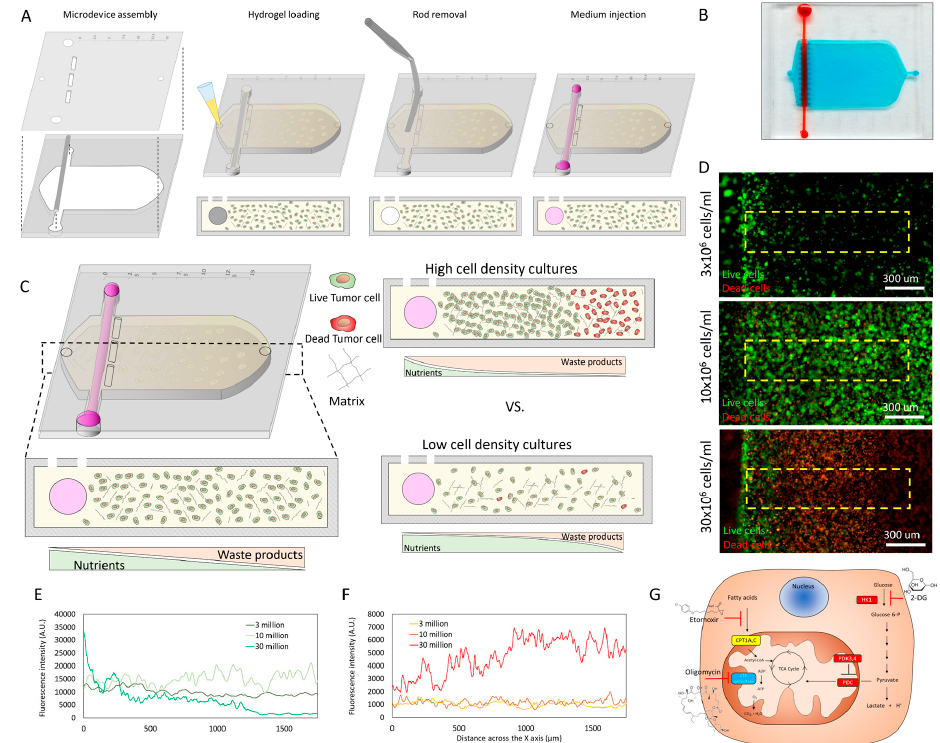
Figure 1. Tumor-on-a-chip platform to evaluate breast cancer metabolic adaptations. ( A ) Schematic description of the microdevice assembly and fabrication. A polydimethylsiloxane (PDMS) rod was placed in the bottom layer of the microdevice layer. Next, the top layer was placed on top, creating a sealed microdevice. A collagen hydrogel mixture containing the cells was pipetted into the central microchamber. After collagen polymerization, the PDMS rod was removed, generating a lumen to perfuse media and nourish the cells. ( B ) Picture of the microdevice. Blue-colored hydrogel was injected in the microchamber, whereas red-colored water was perfused through the lumen for visualization purposes. ( C ) A single lumen in one side of the microdevice allowed us to create gradients of cell viability. A necrotic core could be generated in the microdevice by modifying the cell density used in the microdevice. ( D ) Fluorescence microscopy images showing cell viability in the microdevice. Breast cancer MCF7 cells were cultured in the three-dimensional (3D) hydrogel in the microdevice for 48 h at multiple cell densities (3, 10, and 30 × 10 6 cells/mL). Live cells are shown in green, whereas dead cells appear in red. ( E , F ) Graphs showed the fluorescence intensity profile of live (green line) or dead (red line) across the delimited region shown in panel D (i.e., yellow rectangle). ( G ) Schematic depicting the targets of 2-deoxyglucose (2DG) (i.e., glycolysis inhibitor), etomoxir (i.e., fatty acid oxidation inhibitor), and oligomycin (i.e., adenosine triphosphate (ATP) synthetase inhibitor).